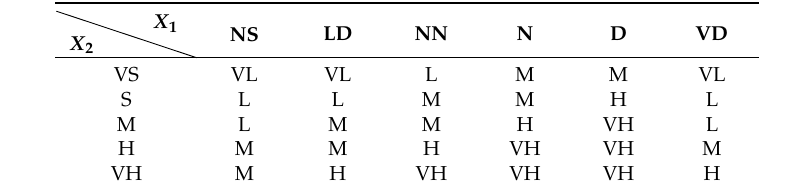
Figure 7. Structure diagram for P 1 _FIS. Table 1. Fuzzy rules in partial 1 FIS.